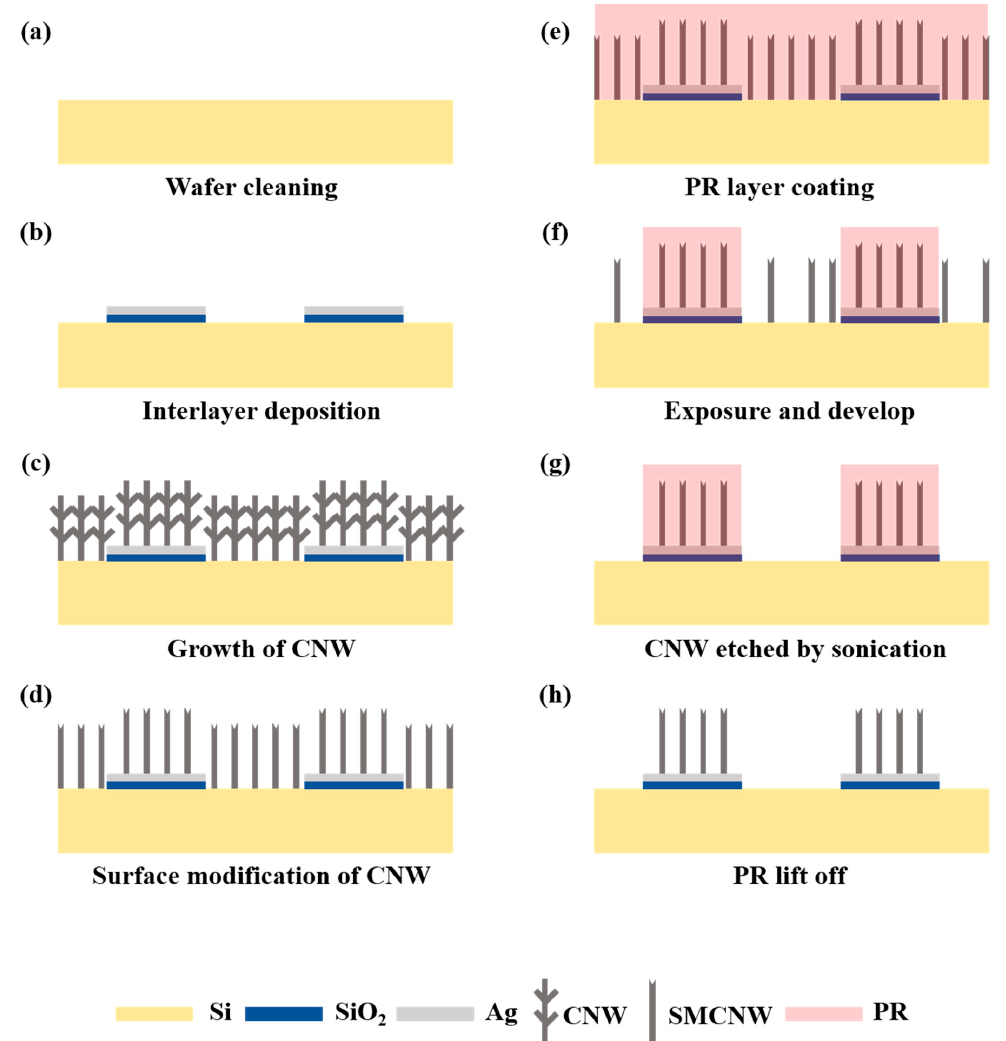
Figure 1. Fabrication process of top-down surface micromachining in surface-modified carbon nanowall. ( a ) Wafer cleaning process; ( b ) Patterning and deposition of Ag/SiO 2 layer; ( c ) Growth of CNW via MPECVD; ( d ) Surface modification of CNW by O 2 plasma; ( e ) Coating the PR layer on the sample; ( f ) Exposure and develop process; ( g ) Surface micromachining of SMCNW by sonication; ( h ) PR lift-off process.